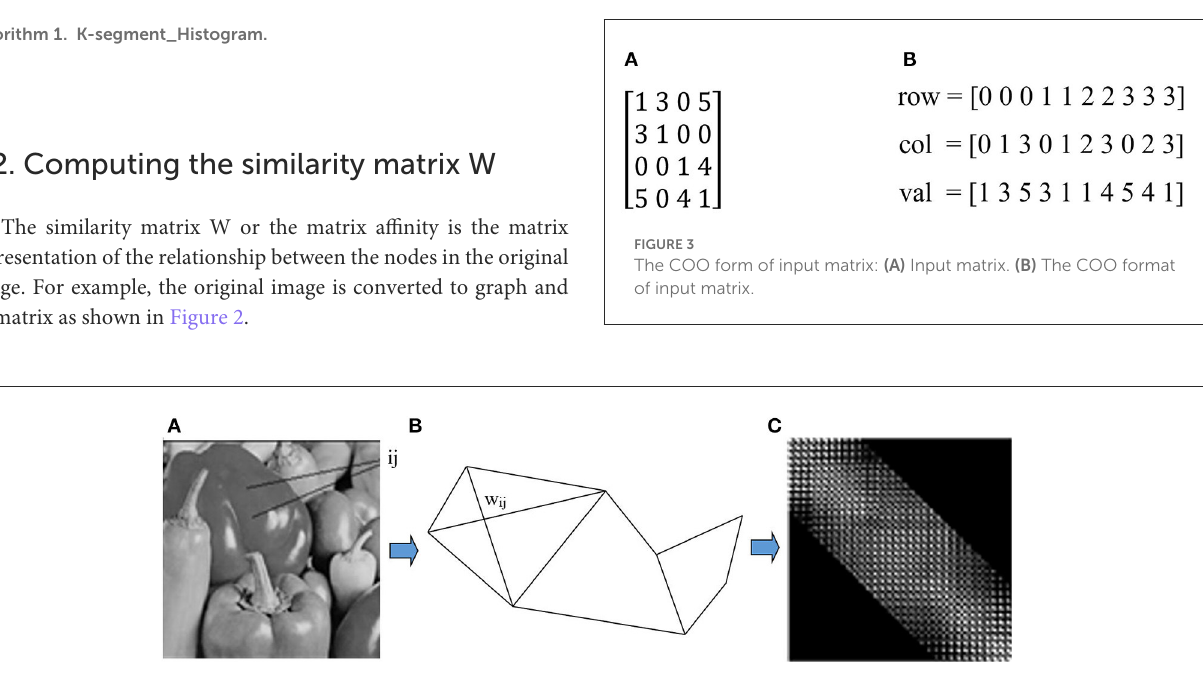
Algorithm 1. K-segment_Histogram.